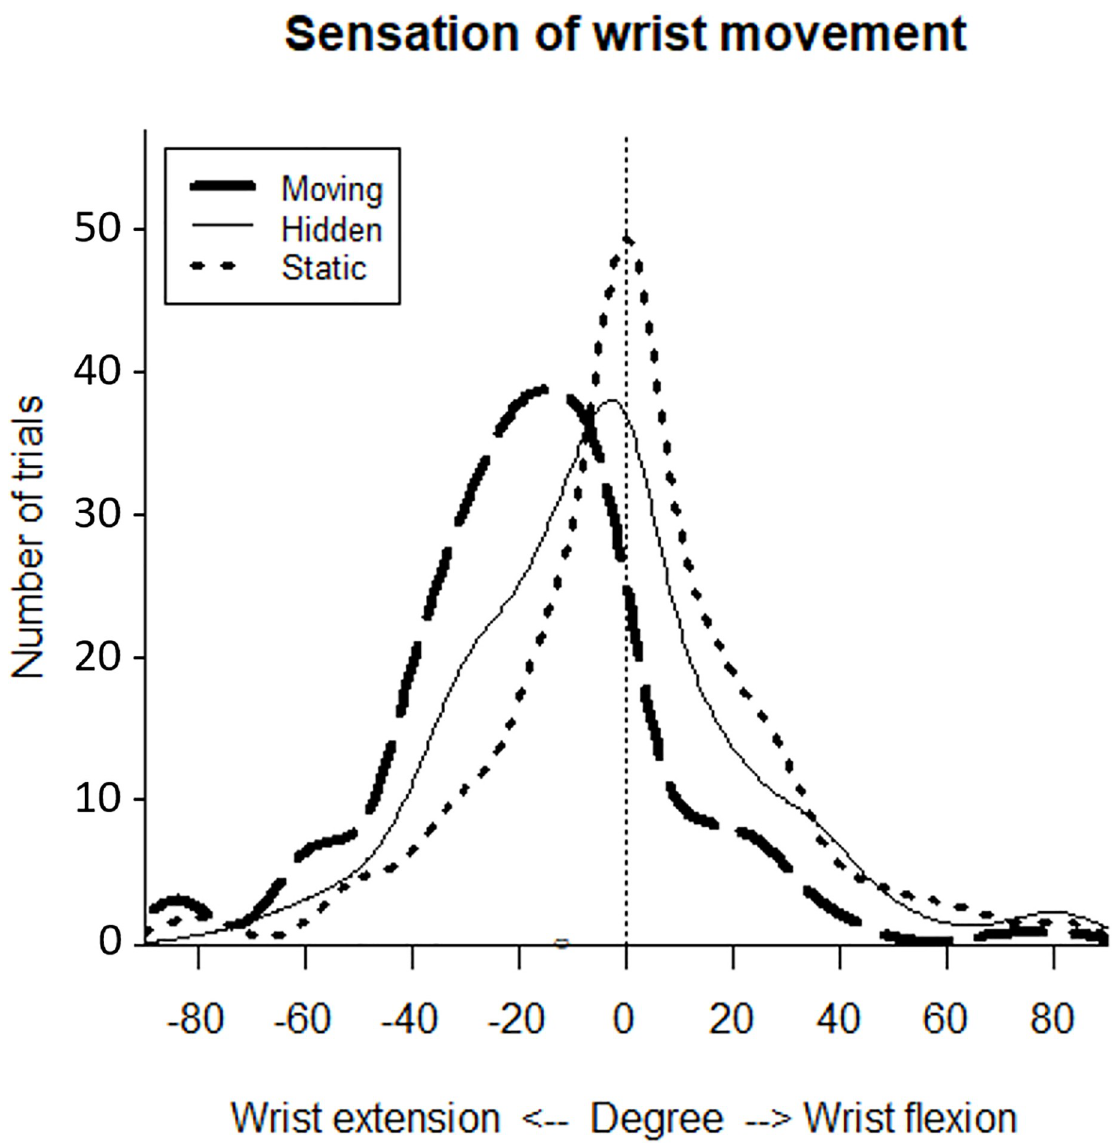
Fig 5. Frequency of sensation of wrist extension. Smoothed histogram of the frequency of sensation of wrist displacement in each condition averaged in healthy controls. The vertical line represents the zero degree axis.